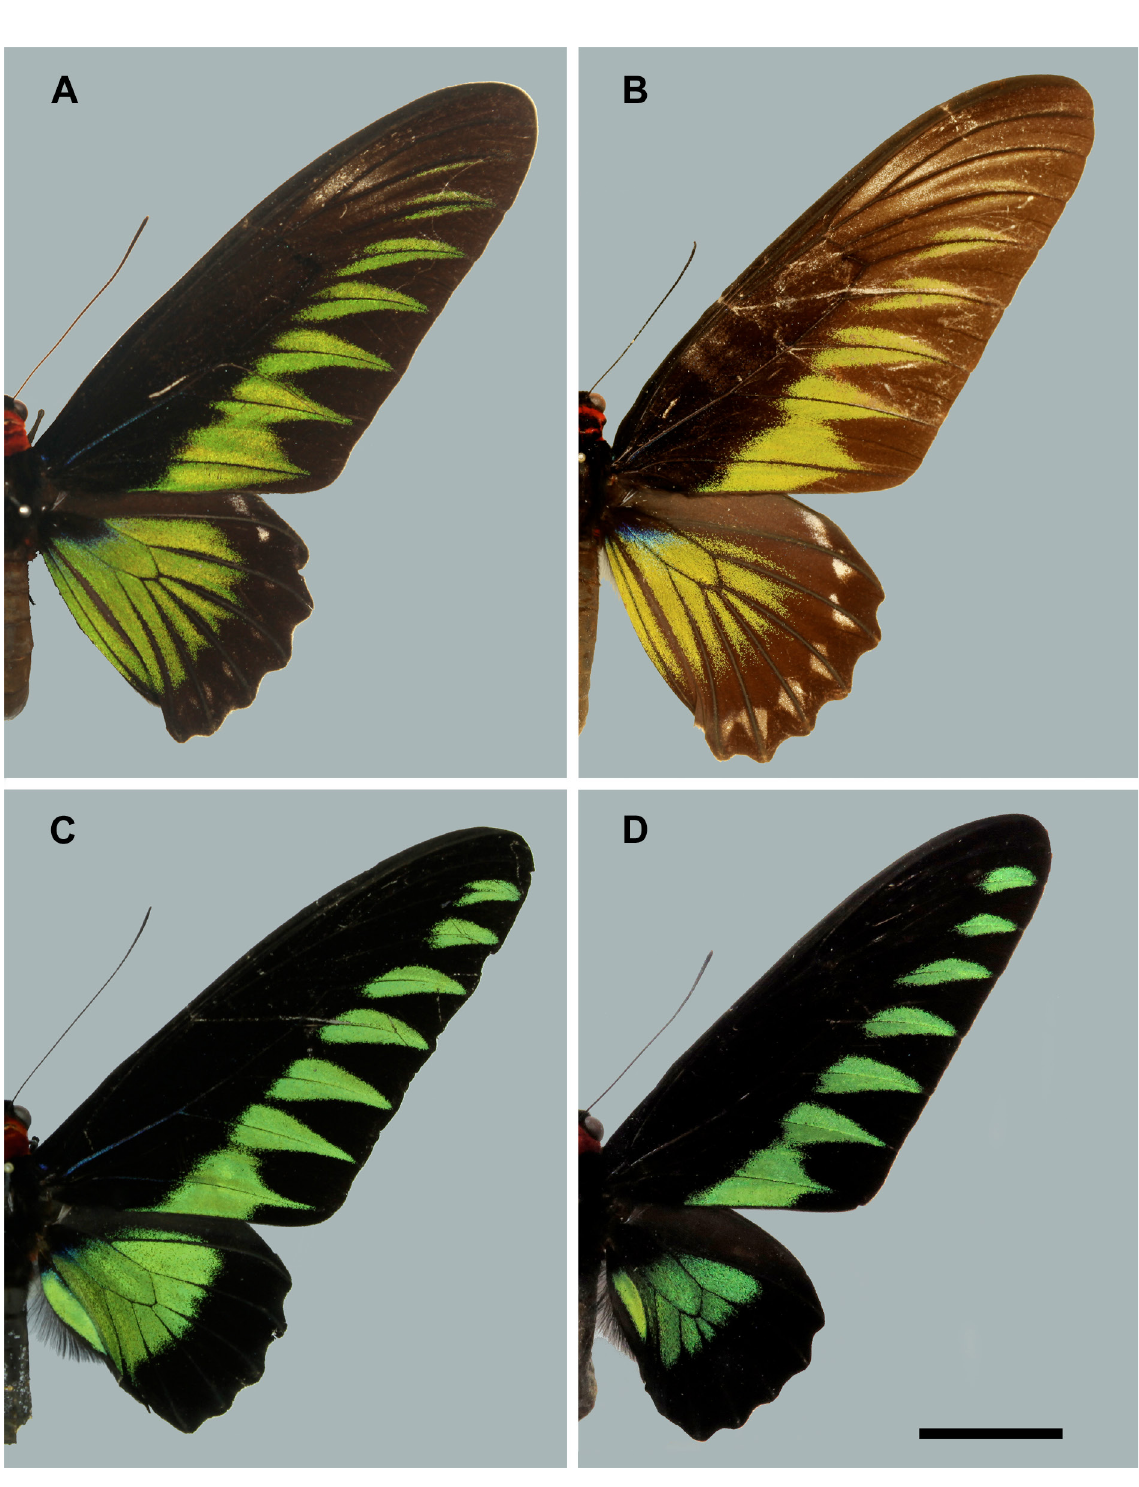
Fig. 4. Females (top) and males (bottom) of Trogonoptera brookiana mollumar d’Abrera, Doggett & Parker, 1976 (A and C) and T. b. trogon (Vollenhoven, 1860) (B and D). Scale bar = 2.00